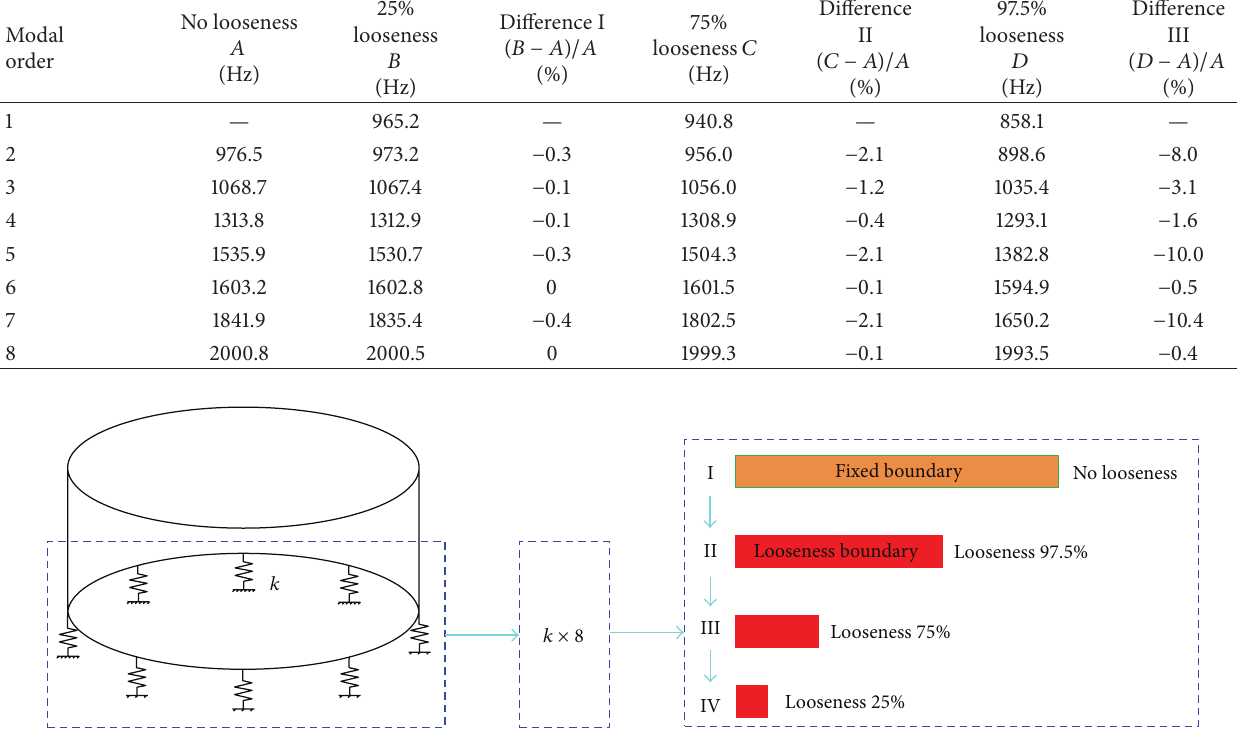
Figure 5: Schematic of different bolt looseness level adopted by FEM.